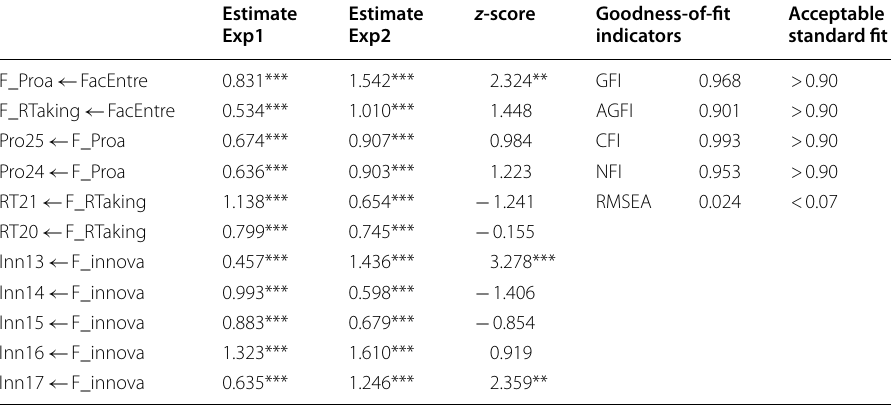
Table 7 SEM results for FEO construct subject to